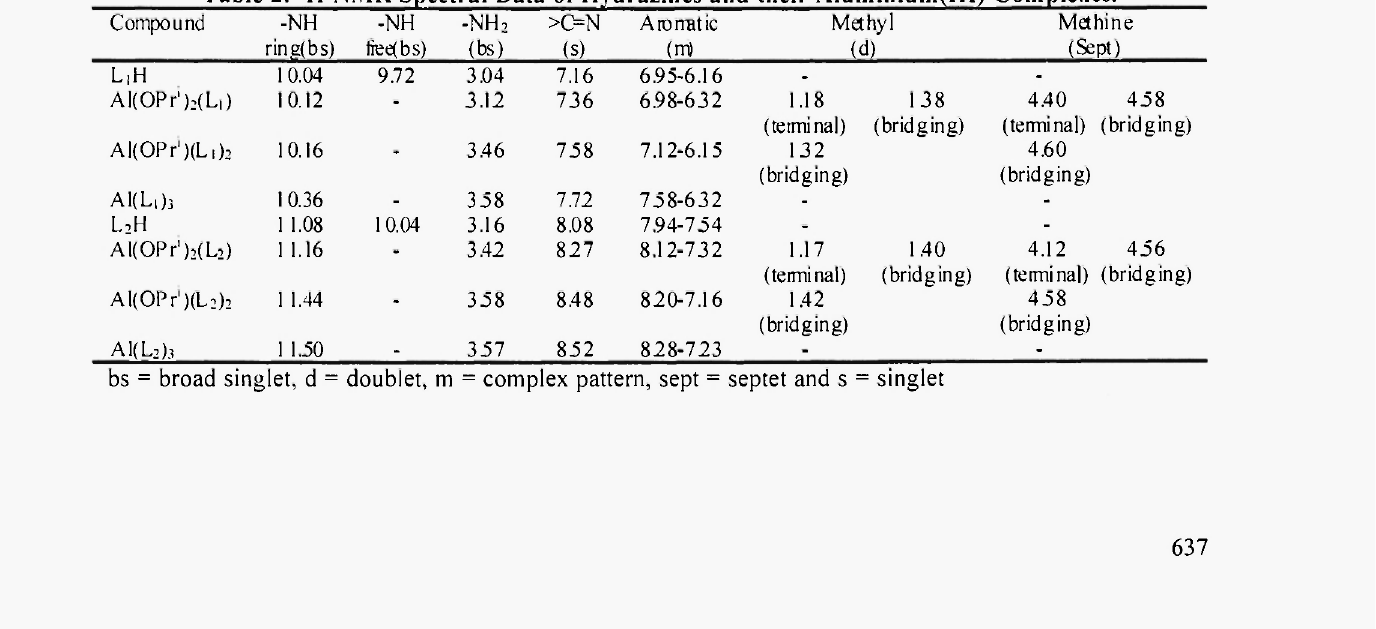
Table 2: 'H NMR Spectral Data of Hydrazines and their Aluminium(HI) Complexes.